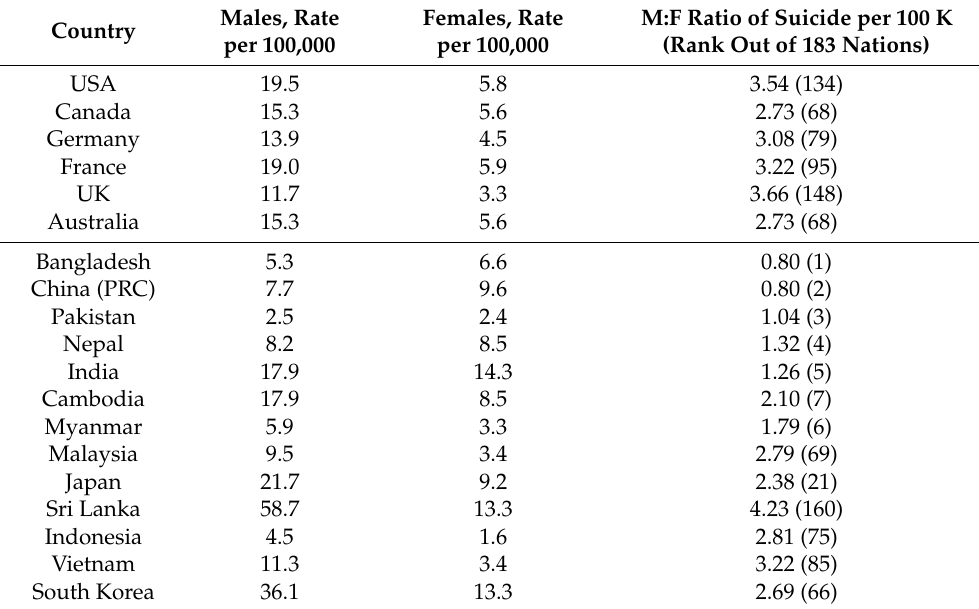
Table 1. World Health Organization (WHO) Data on Suicide Rates by Gender, Selected Countries, 2015. Males, Rate Females, Rate M:F Ratio of Suicide per 100 K Country per 100,000 per 100,000 (Rank Out of 183